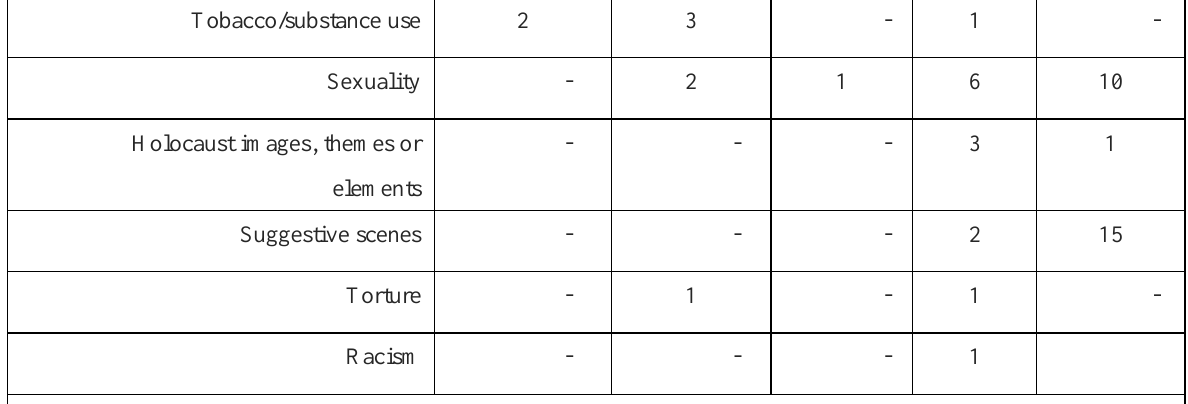
Table 1: Distribution of core content terms across